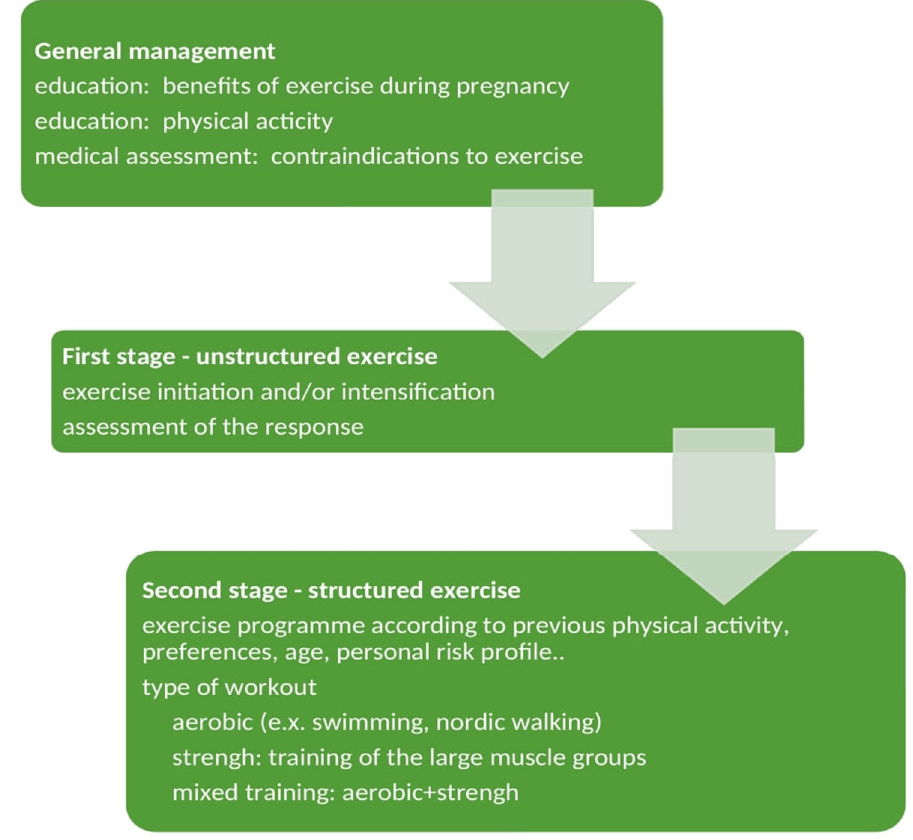
Figure 3. The principles of introducing and expanding physical exercise in pregnancy. Not all physical activities are advisable for pregnant women. Examples of safe and unsafe exercise during pregnancy are shown in Table 4 [33,348]. Table 4. Safe and unsafe exercise during pregnancy.